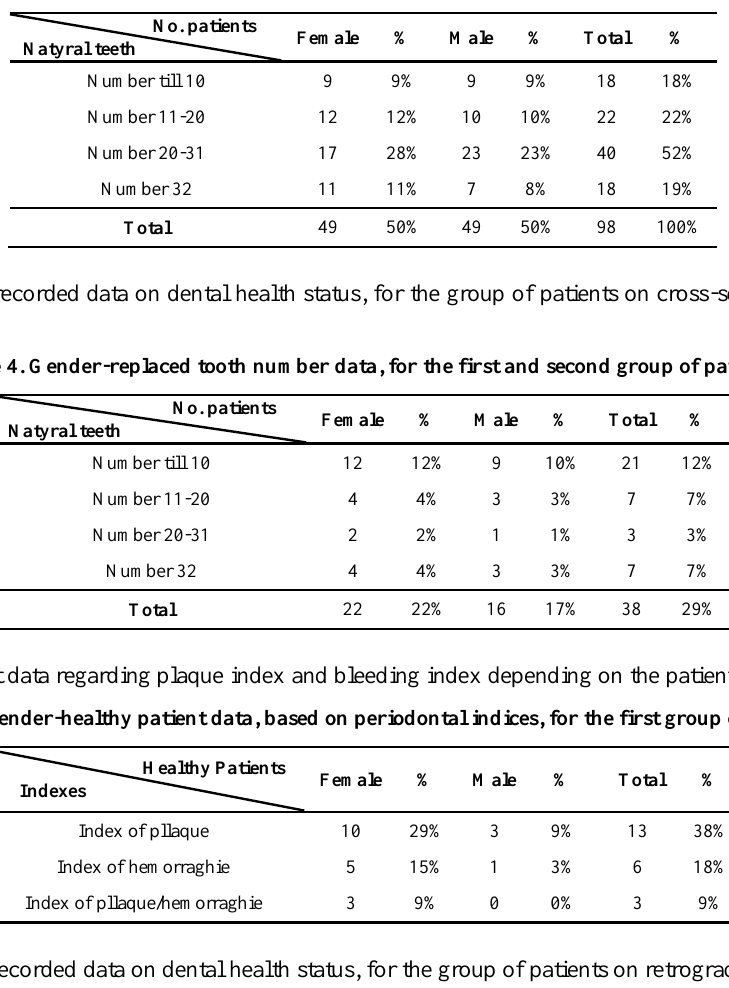
Table 3. Natural tooth number-gender data, for the first and second group of patients